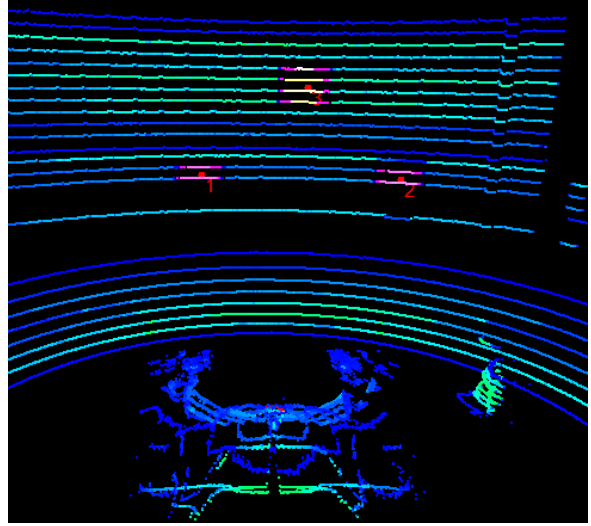
Figure 6. Target points (magenta color) in the point cloud captured by Velodyne HDL-32E scanner. After segmenting the target points from the background, the next plane, defined as the best fitting plane to the points. Figure 7